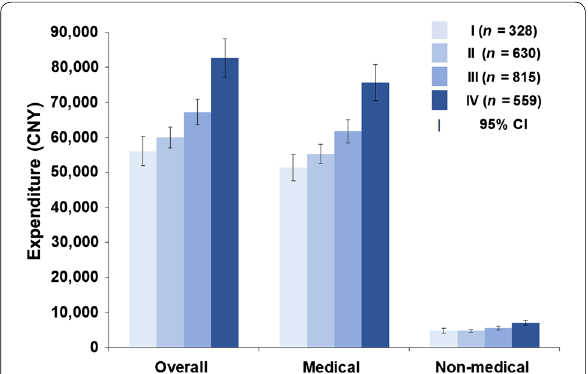
Fig. 1 Medical and non‑medical expenditures for diagnosis and treatment of patients with stage I–IV colorectal cancer. CNY Chinese Yuan, CI confidence interval. Of the 2356 patients included, 24 have no information of clinical